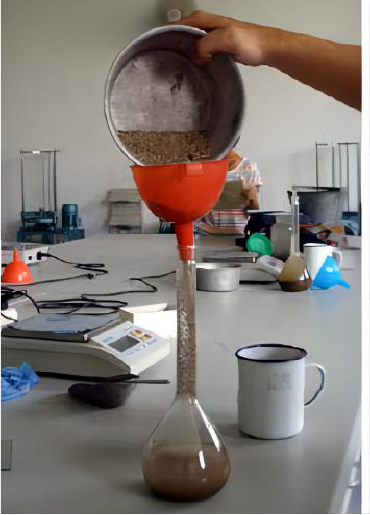
Figure 2. Sand apparent density test.